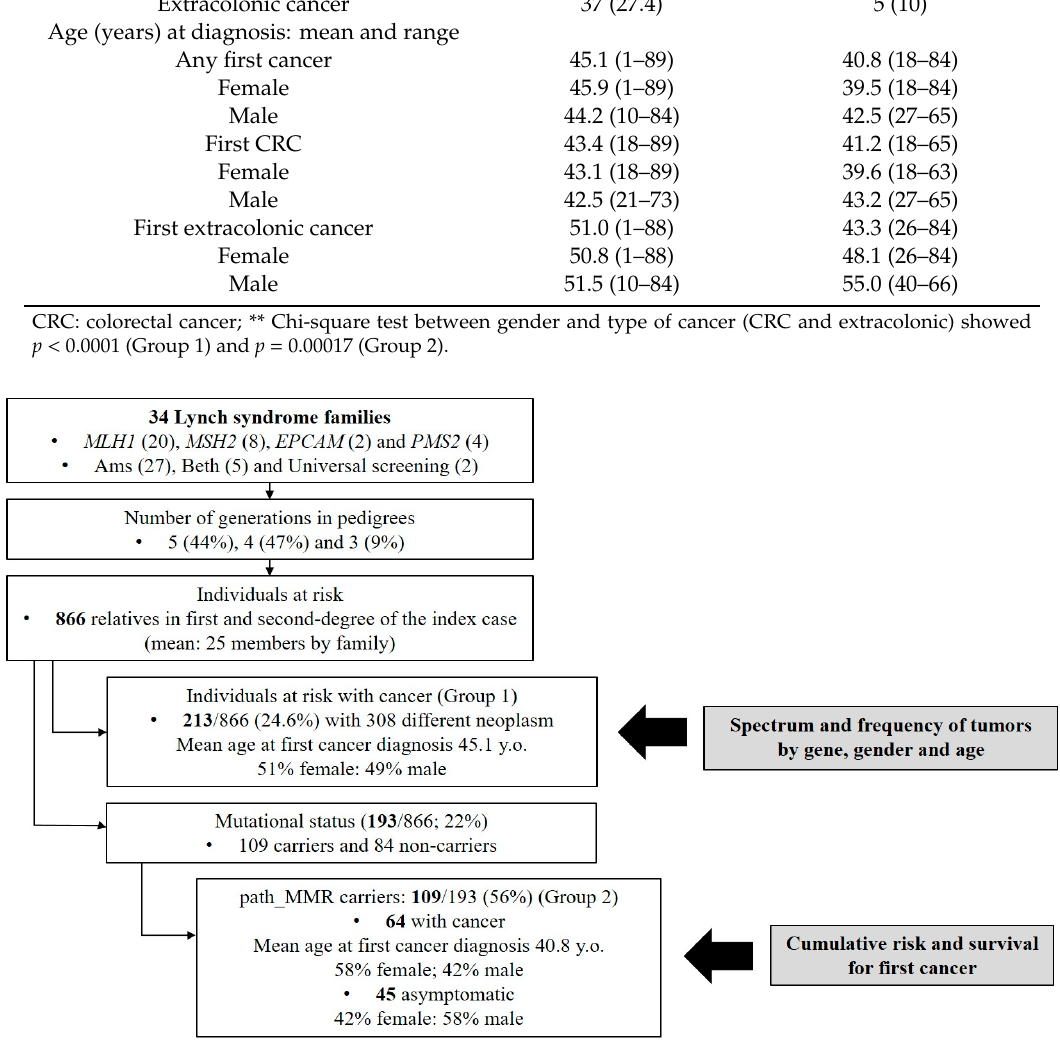
Figure 2. Flowchart of analysis.